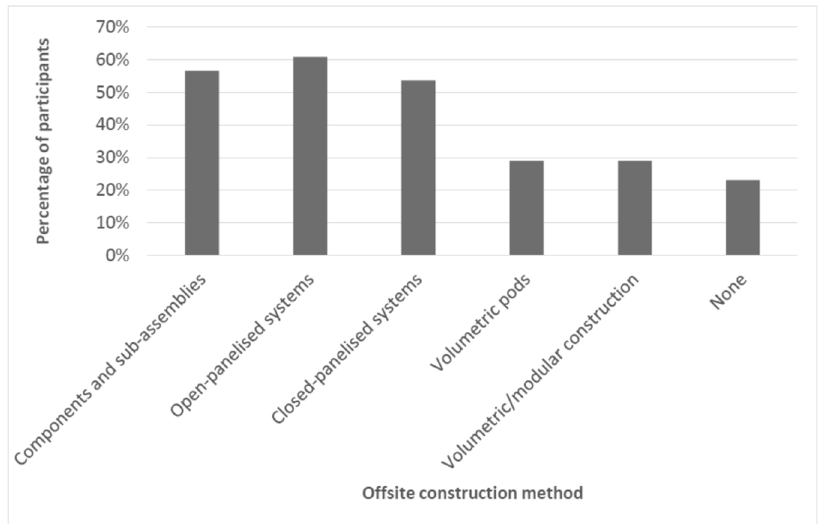
Figure 4. Distribution of experience in given types of the offsite construction method. (Direct expe- rience was stated as “You have been directly involved in a project where the following offsite con- struction methods were considered or